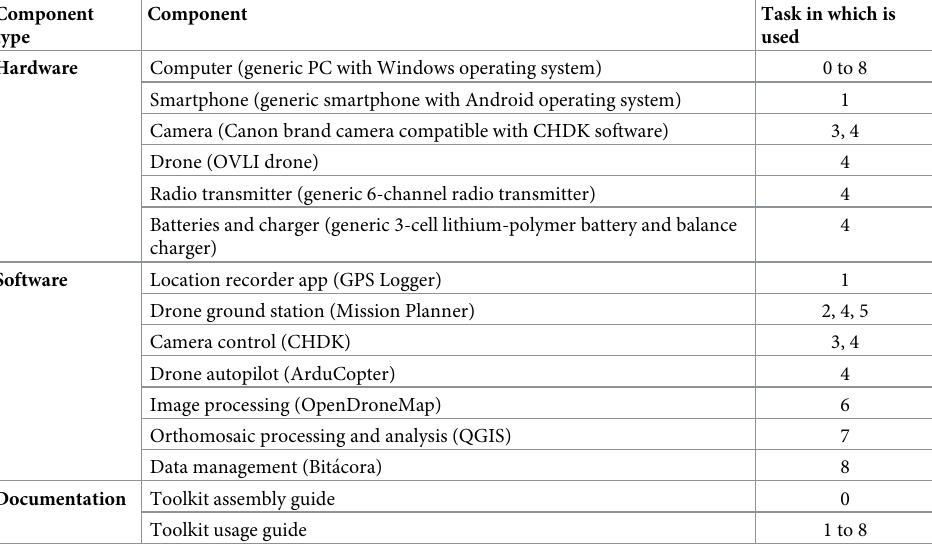
Table 2. Summary of the hardware, software, and documentation components of the Open Science Drone